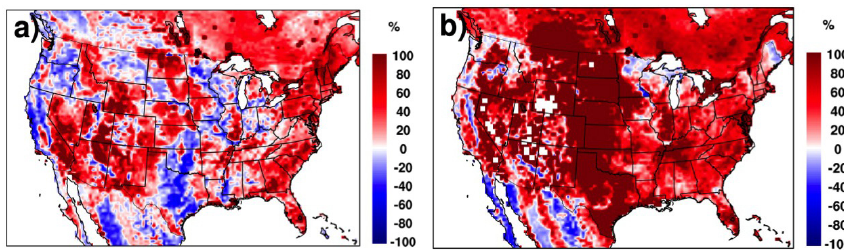
Figure 11. Percent change between future and current decade summertime emissions for future climate and land use for (a) isoprene and (b)